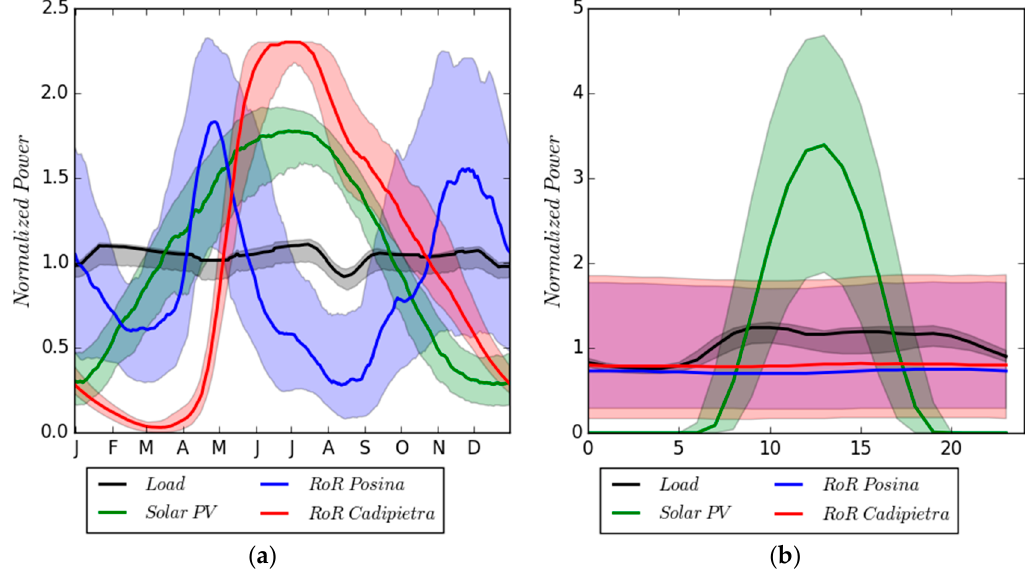
Figure 3. Annual ( a ) and daily ( b ) average cycles of simulated energy load (black) and simulated energy generation (i.e., solar PV generation (green) and RoR power generation from the snow- (red) and rain-dominated (blue) catchments and for the present climate (1992–2009). Bold curves represent the median cycle while shaded areas show distance between 25th and 75th percentiles. The time step used is hourly for daily cycles and daily for annual cycles (For illustration, all the cycles have been normalized to their average value. Hence, the average value of the cycles equals 1).